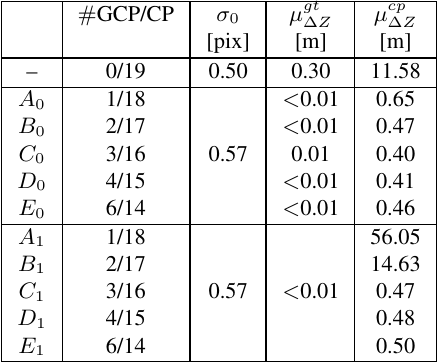
Table 3: Oregon; σ 0 – bundle adjustment standard deviation, µ gt GCPs, and µ cp – on CPs.; both derived from LiDAR point ∆ Z